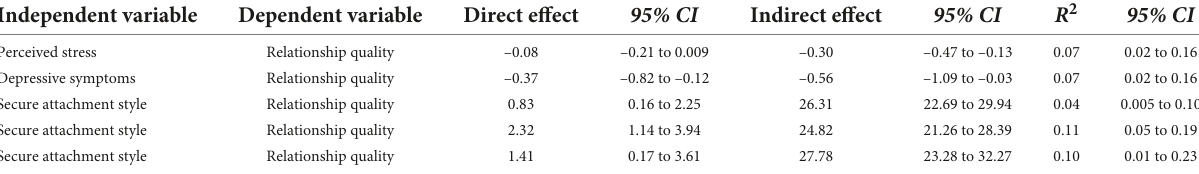
TABLE 11 Values of direct and indirect effects as well as the value of the R 2 coefficient together with 95% confidence intervals in individual mediation analyzes. Independent